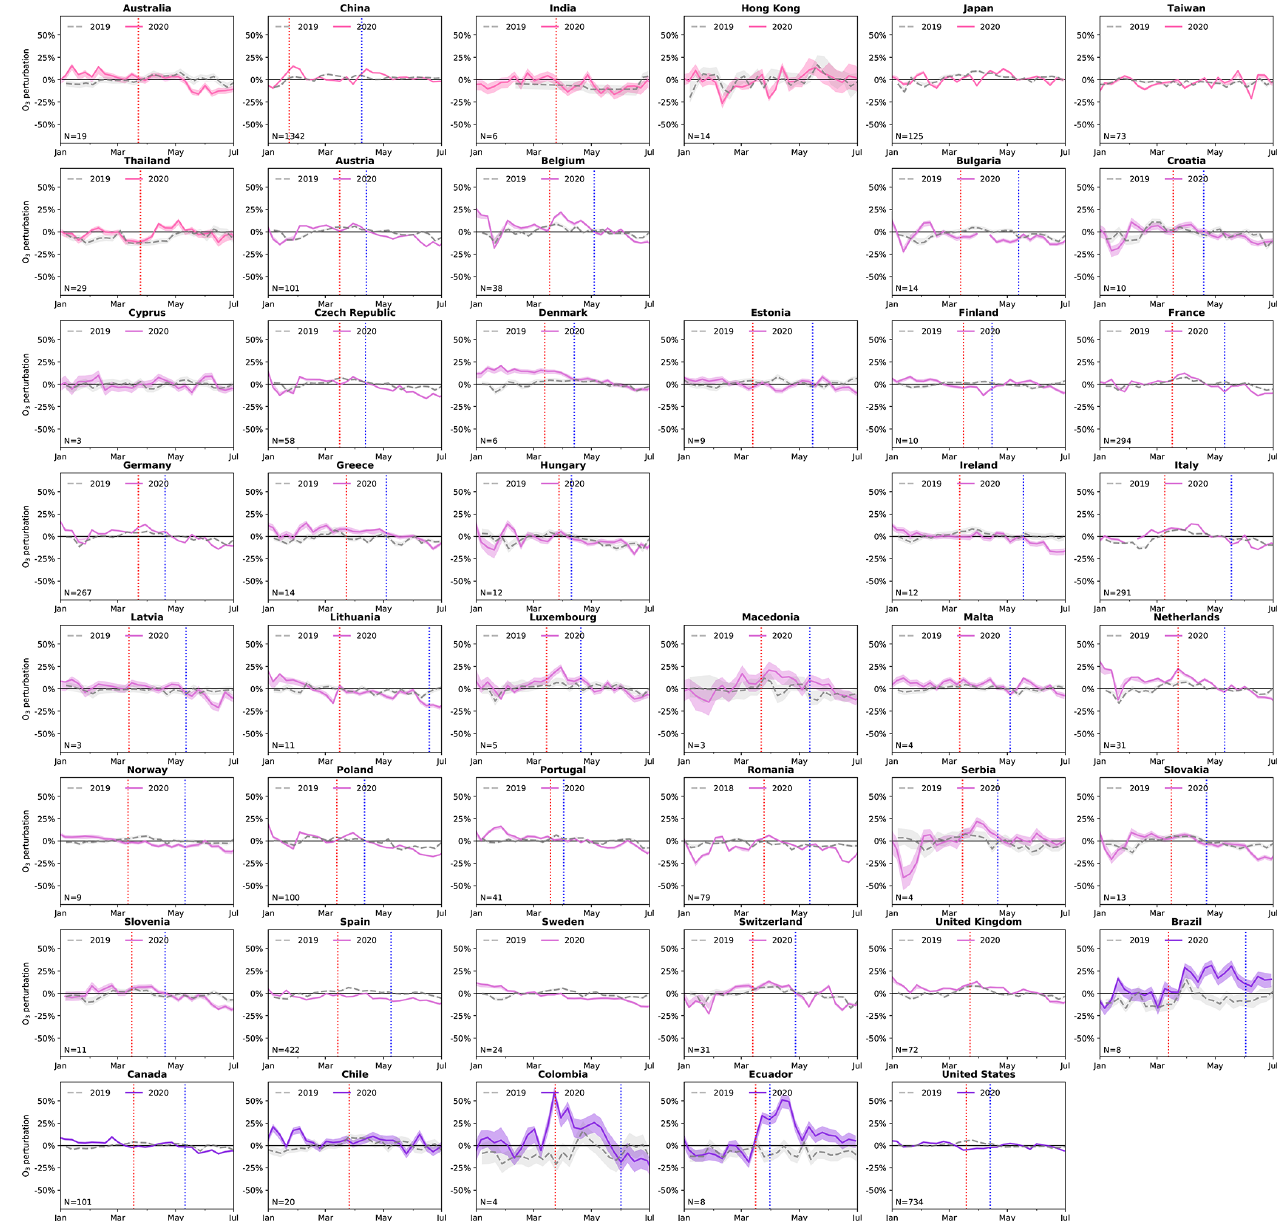
Figure 7. Similar to Fig. 5 but for O 3 and without Bosnia and Herzegovina and Iceland. Differing colors indicate differing regions (pink: Asia and Australia; light purple: Europe; dark purple: